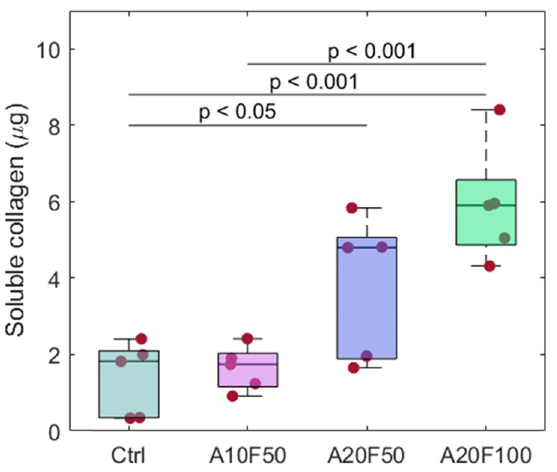
Figure 3. Collagen production at 72 h, Ctrl, A10F50, A20F50, and A20F100, n = 5.